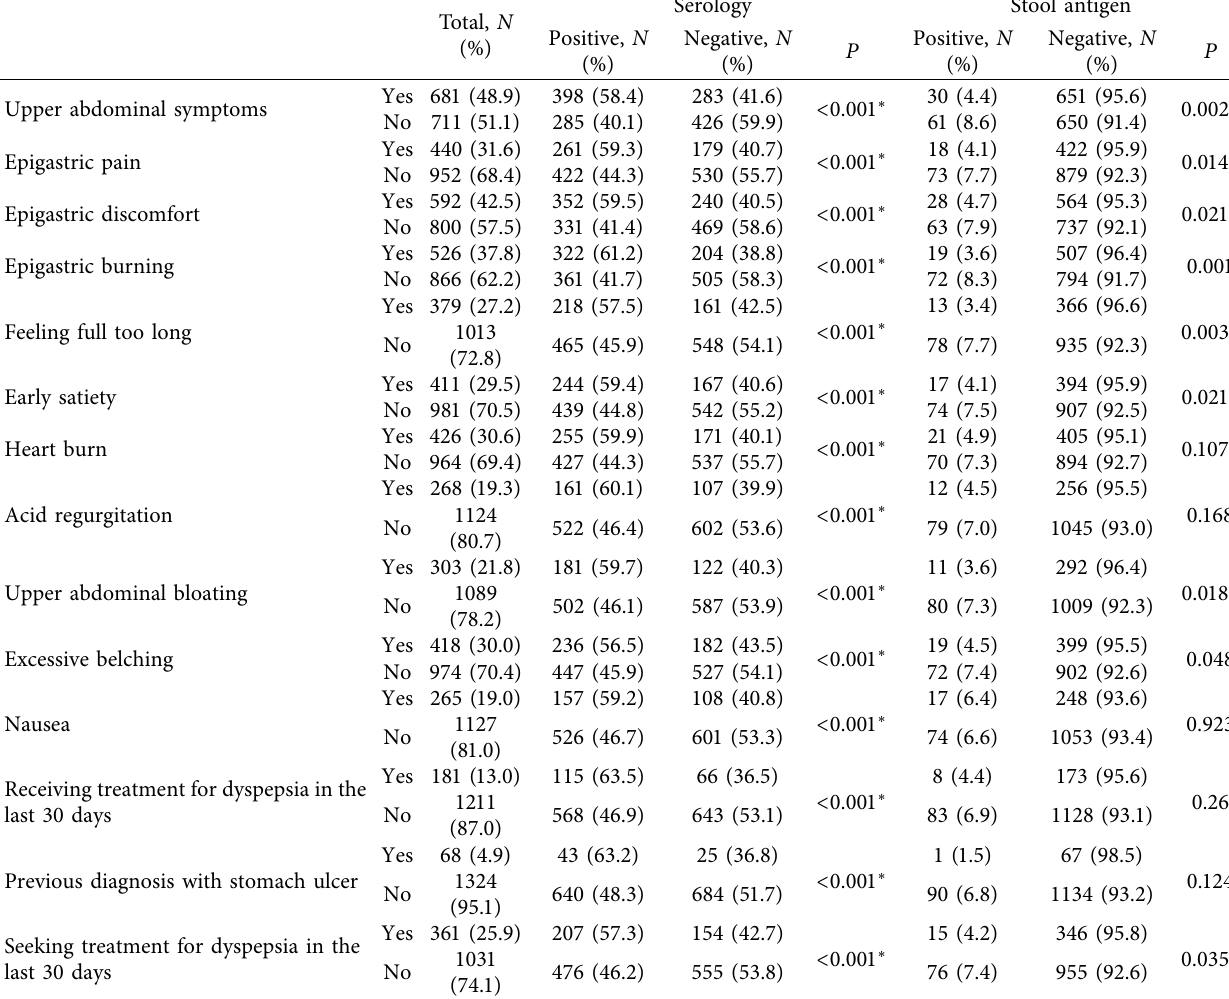
Table 2: H. pylori serology and stool antigen test positivity among people with symptoms of dyspepsia. Total,